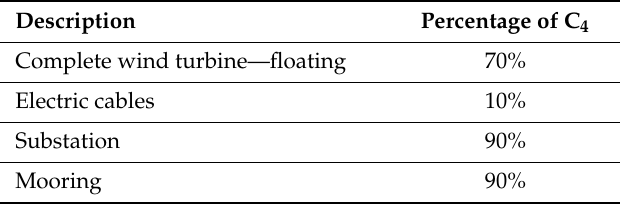
Table 1. Decommissioning costs (% of C 4 ). Source: